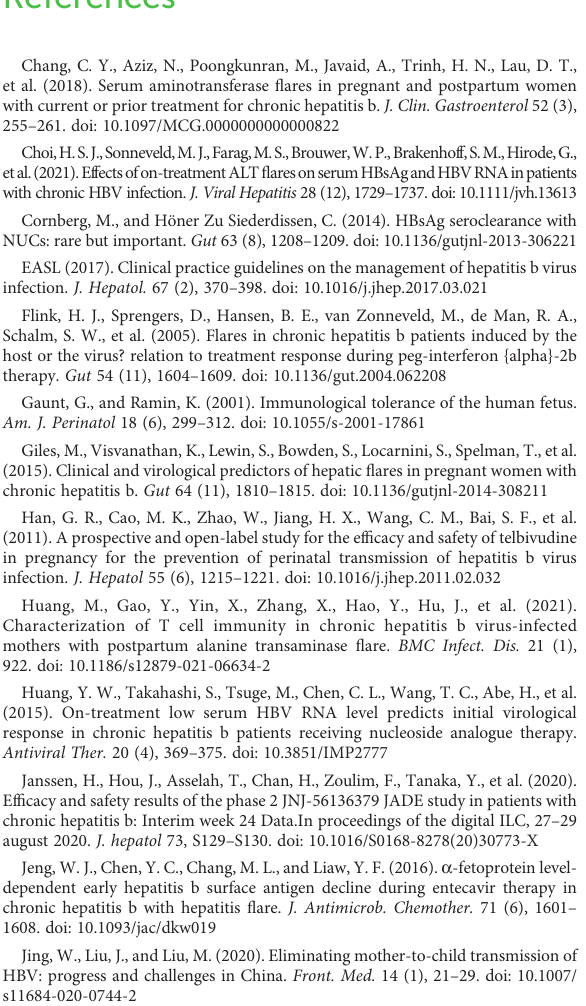
SUPPLEMENTARY FIGURE 1 The fl ow chart of a process for identifying eligible patients. CHB, Chronic hepatitis B; MTCT, Mother to child transmission; HBsAg reduction, HBsAg decrease >0.3log 10 IU/mL from baseline to last date of follow-up. SUPPLEMENTARY FIGURE 2 The changing pattern of HBsAg and ALT levels for each patient with HBsAg reduction (N=13) during follow-up. SUPPLEMENTARY FIGURE 3 Correlation of pgRNA, HBcrAg levels and other HBV markers in pregnant CHB carriers with HBeAg positive. A) Correlation matrix of parameters. The size of circle is proportional to Spearman ’ s correlation coef fi cient. B) Scatterplots of serum pgRNA or HBcrAg levels (y-axis) vs. other HBV parameters. R= Spearman ‘ s correlation coef fi cient; P = P value of correlation t-test. Baseline, 24-28 weeks of gestation; near delivery, 32- 36 weeks of gestation; postpartum, 2-6 weeks after delivery. SUPPLEMENTARY FIGURE 4 Calibration curve for the combined prediction model to predict probability of HBeAg